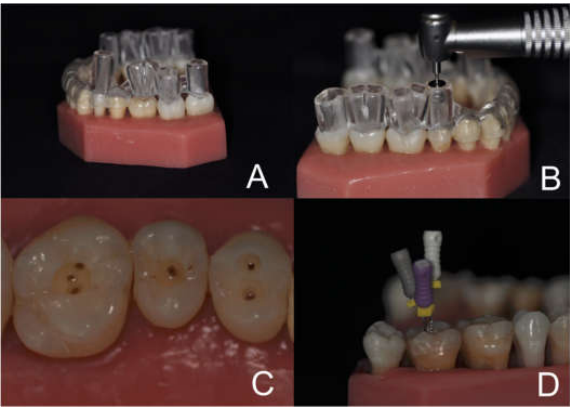
Figure 2. Access cavity preparation: ( A ) CAD/CAM-fabricated template placed on a model, ( B ) sleeve inserted for static navigation of the bur, ( C ) access cavity preparations in maxillary premolars and molar, ( D ) locating three main root canals with endodontic hand files.